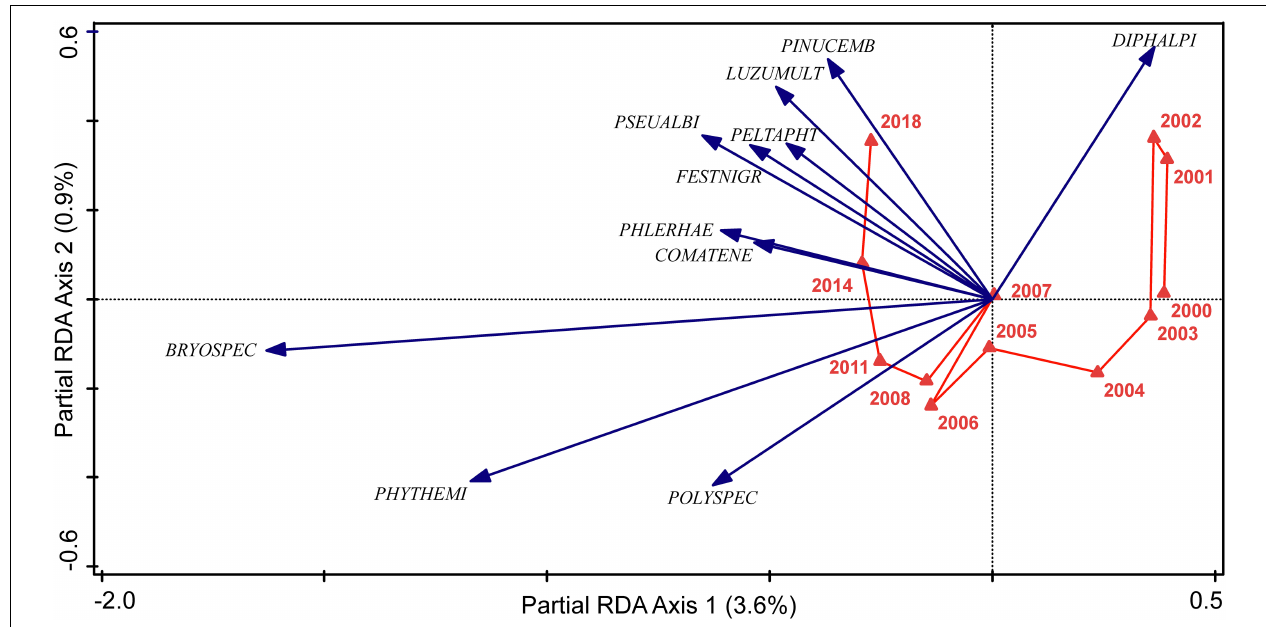
FIGURE 2 | Changes of the grazed sites from 2000 to 2018. The most relevant species (fit > 2%) are plotted as vectors (POLYSPEC = Polytrichum species, PHYTHEMI = Phyteuma hemisphaericum , BRYOSPEC = brophyte species, COMATENE = Comastoma tenellum , PHLERHAE = Phleum rhaeticum , FESTNIGR = Festuca nigrescens , PSEUALBI = Pseudorchis albida , PELTAPHT = Peltigera aphthosa , LUZUMULT = Luzula multiflora , PINUCEMB = Pinus cembra , DIPHALPI = Diphasiastrum alpinum ). Partial RDA with plot as covariate, Monte-Carlo p = 0.0002, explained variation of axes indicated.